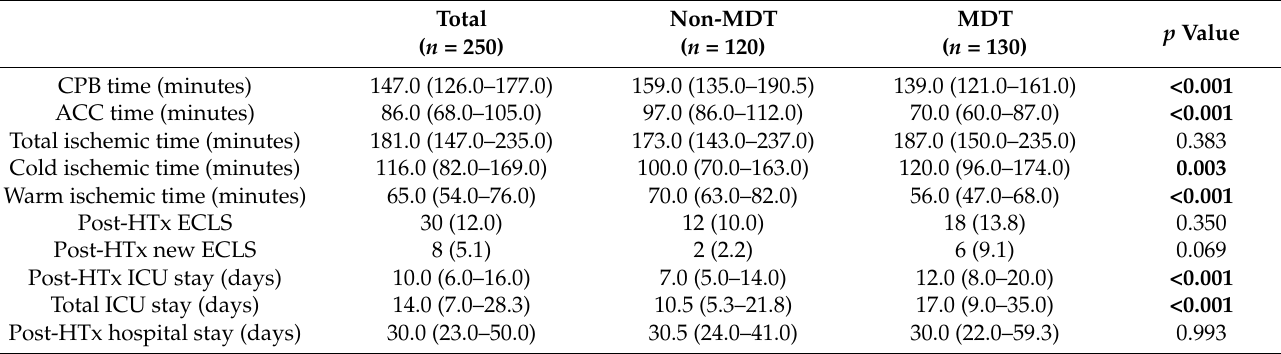
Table 2. Operative and postoperative characteristics of all